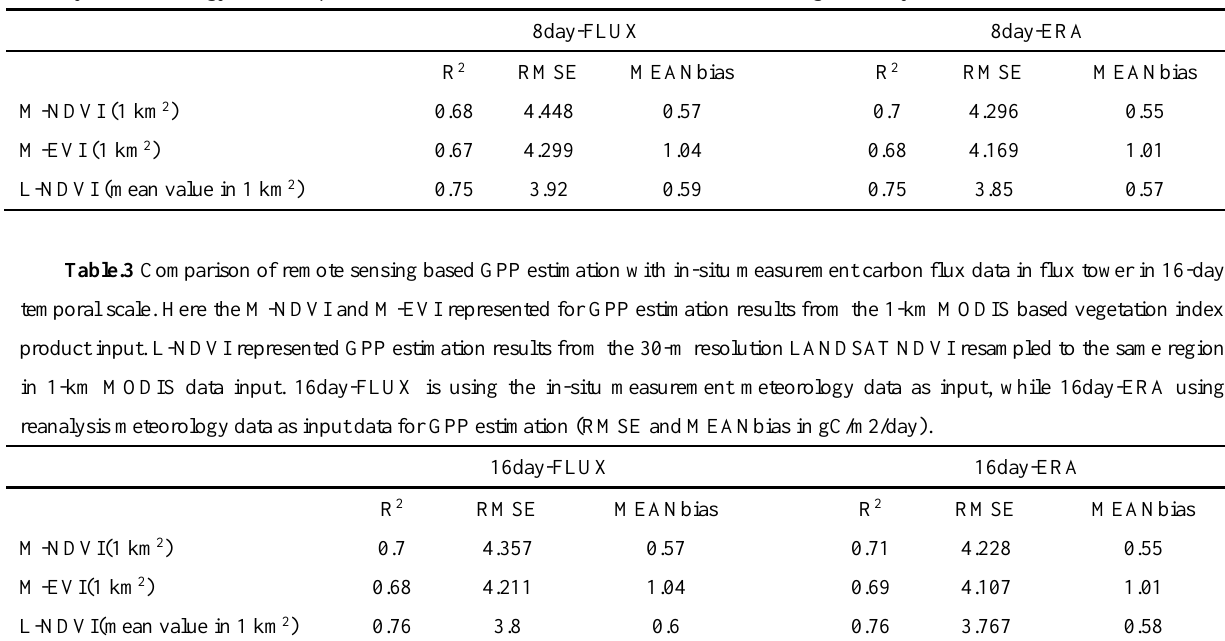
Table.2 Comparison of remote sensing based GPP estimation with in-situ measurement carbon flux data in flux tower in 8-day temporal scale. Here the M-NDVI and M-EVI represented for GPP estimation results from the 1-km MODIS based vegetation index